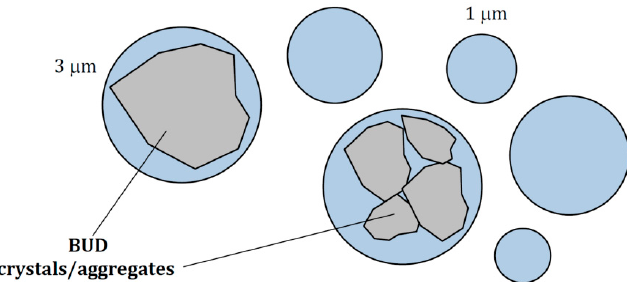
Figure 11. Possible geometric limitations for BUD particles/aggregates contained inside aerosol droplets (droplet diameter 1–3 µ m). The smallest droplets may contain no BUD particles.